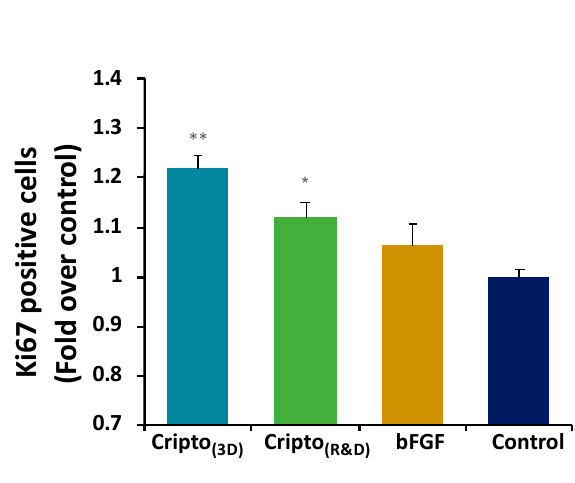
Figure 5. Proliferation analysis using Ki67 immunostaining of C2C12 myoblasts after treatment with Cripto produced in 3D microcarriers. C2C12 myoblast proliferation was evaluated by a Ki67 im- munostaining assay after being cultured for 48 h in serum-free medium containing Cripto produced in 3D microcarriers (Cripto (3D) ) or commercially available Cripto (Cripto (R&D) ). Also evaluated were a bFGF medium positive control and a serum-free medium negative control. ( A ) Representative bright field images of myoblasts showing the morphology of the cells in the different treatments. Fluorescence staining for the cell proliferation marker Ki-67 (red) is shown for the different treat- ments. Scale bar 100 µ m. ( B ) Ki67 levels were quantified and presented as fold change over control (serum-free medium). The proliferative effect of Cripto (3D) was compared with that of commercial Cripto (R&D) . Results are shown as mean ± S.D. of at least three independent experiments. * indicates p < 0.05, ** indicates p <